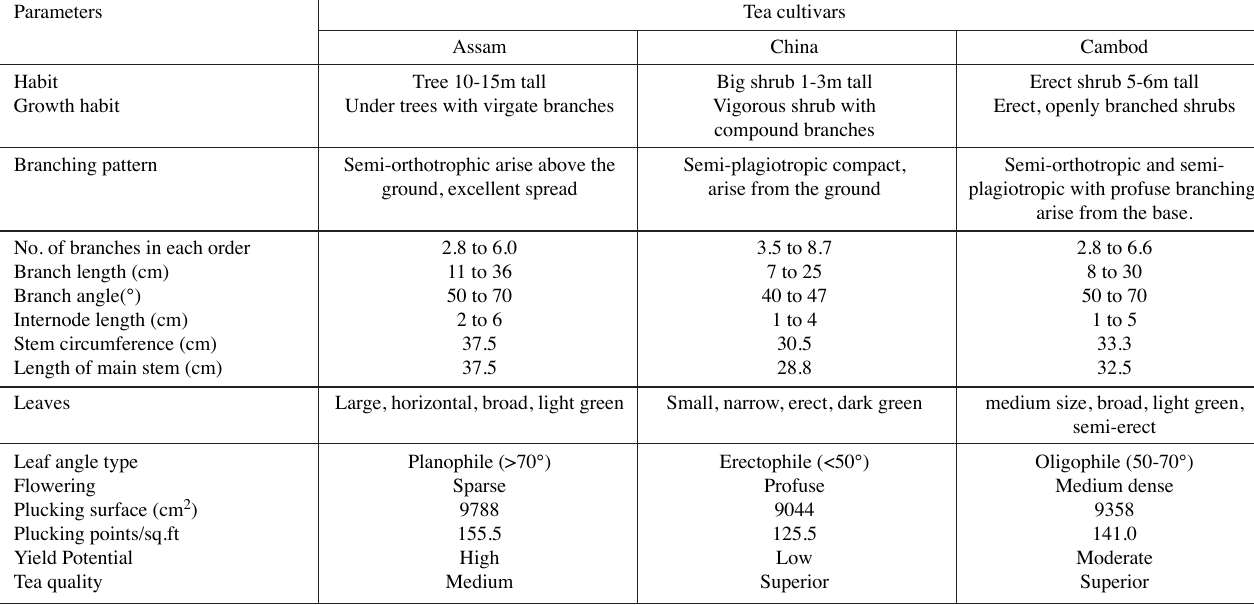
Tab. 1: Comparison of architectural parameters of different tea cultivars